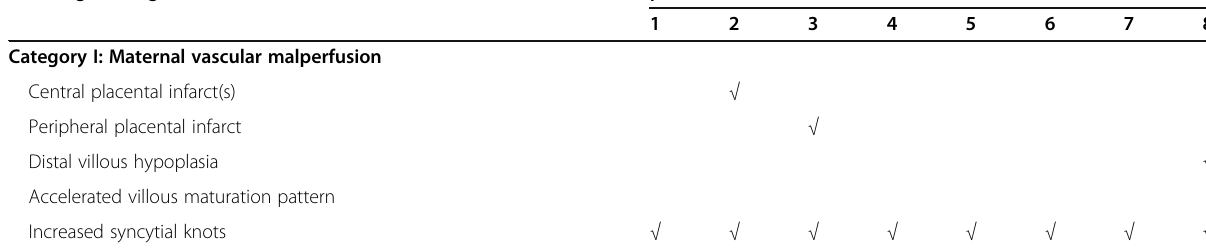
Table 2 Pathological examination of the placental samples of the pregnant women with COVID-19 pneumonia Pathological